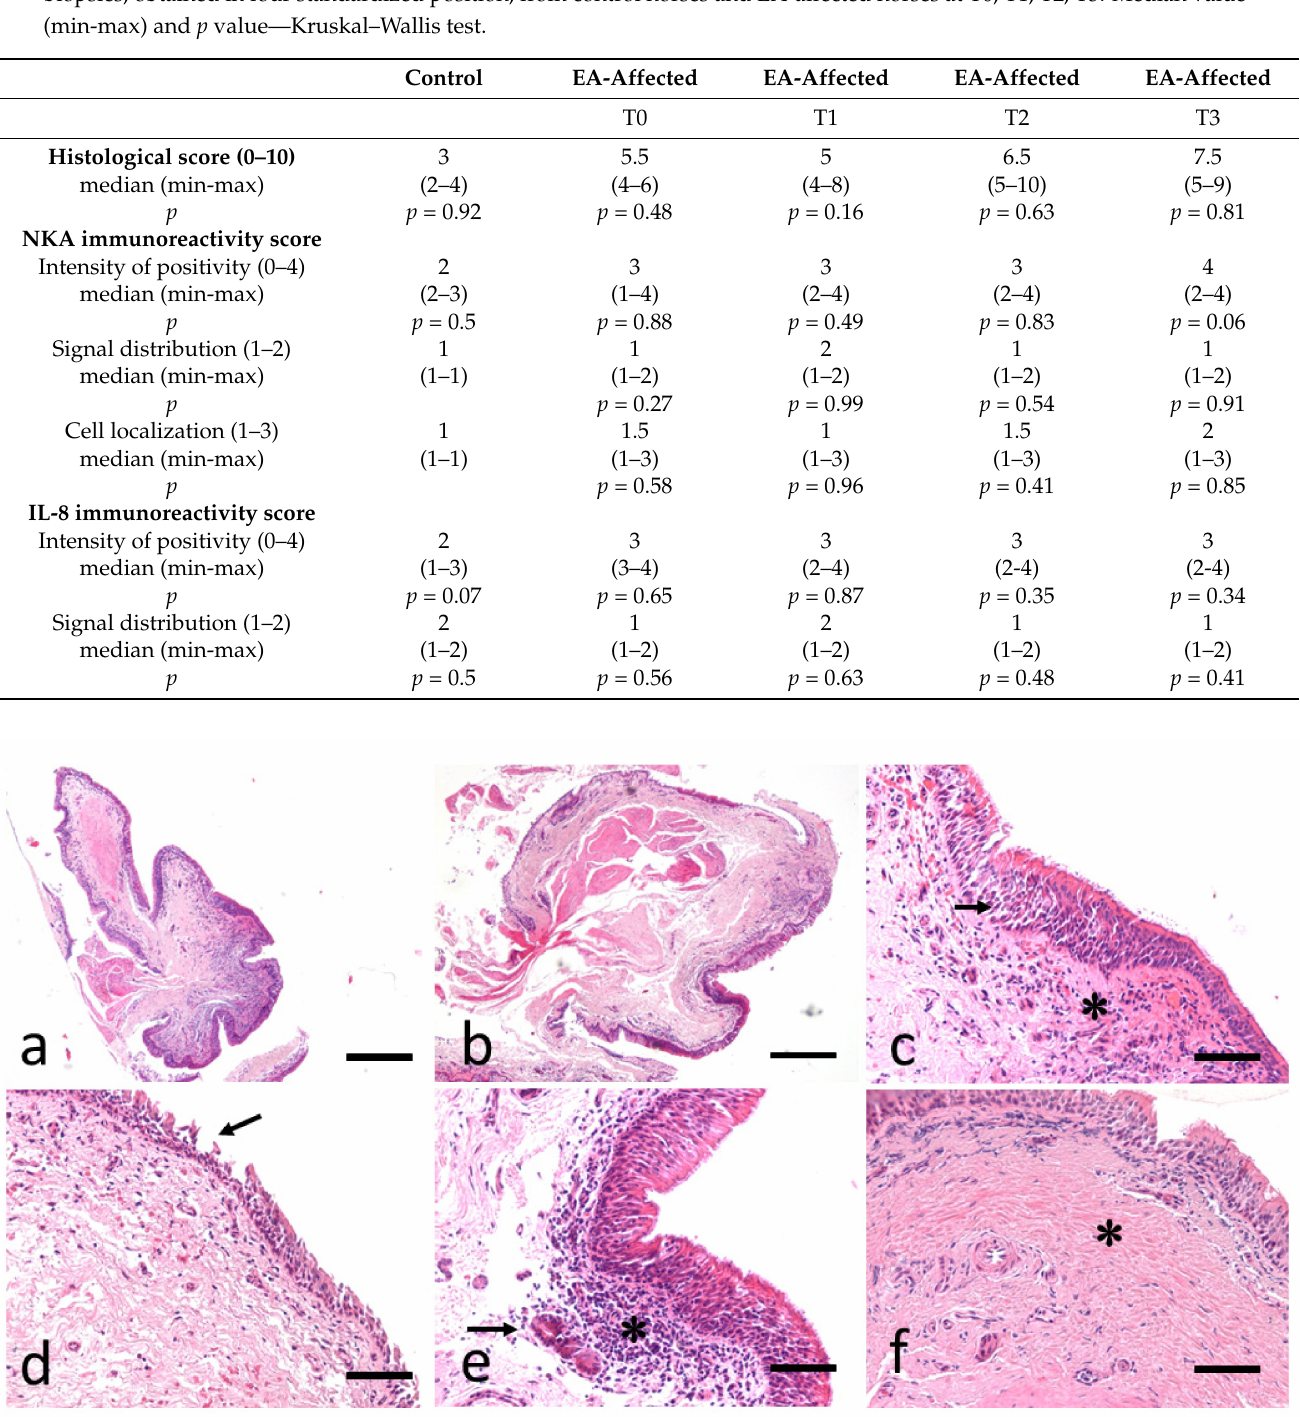
Figure 3. Examples of histological samples of bronchial biopsy in the EA horses. ( a , b ). Low-magnification images of biopsies, obtained with tissue twisting technique with biopsy forceps before tearing. All tissue layers are observed (surface epithelium, extracellular matrix and airway smooth muscle). HE, bar 800 µ m. ( c ) Marked mucosal hyperplasia (arrow), and the presence of a moderate inflammatory submucosal infiltrate of lymphocyte (asterisk). HE, bar 200 µ m. ( d ) Epithelial desquamation involving over 70% of the mucous layer (arrow). HE, bar 200 µ m. ( e ) Severe diffuse lymphocytic infiltrate (asterisk) and presence of mucosal gland (arrow). HE, bar 200 µ m. ( f ) Severe submucosal fibrosis (asterisk). HE, bar 200 µ